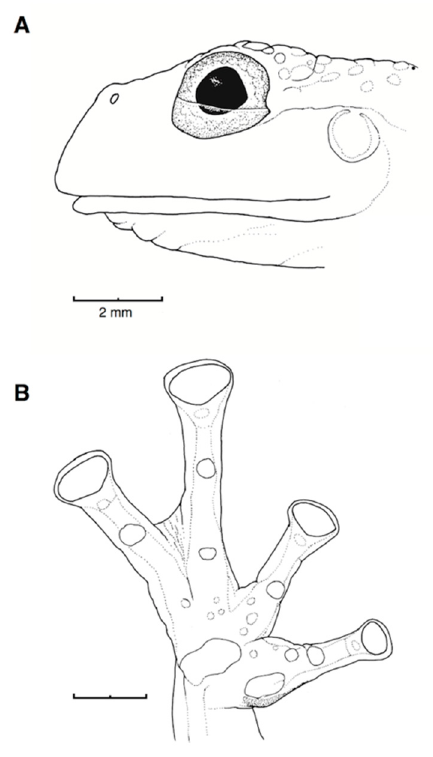
Figure 38. Centrolene heloderma , male, KU 164718. ( A ) Head in ventral view. ( B ) Hand in ventral view. Illustrations by Juan M. Guayasamin.